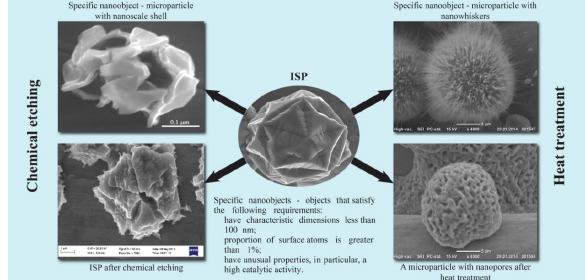
Figure 3: Various configurations of SGS objects produced by elec- trodeposition under mechanical steering. For a brief overview and related references the reader can consult [24] (E.C. Aifantis, Rev. Adv. Mater. Sci. 2017).